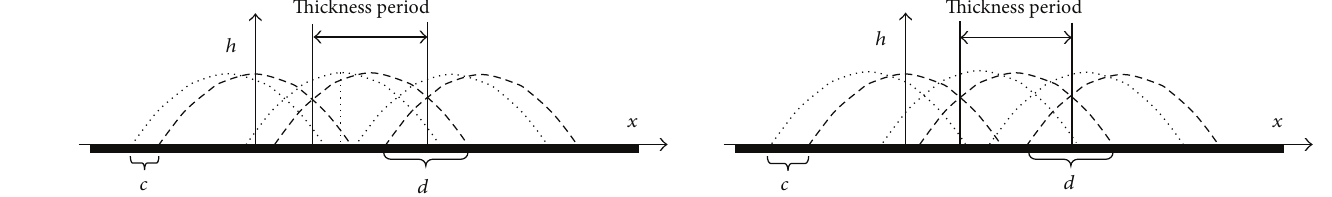
Figure 7: Coating thickness distribution when 𝑐 ≤ 0.5𝑑 , 𝑐 + 𝑑 > 0.5 and 𝑐 + 2𝑑 > 1 .